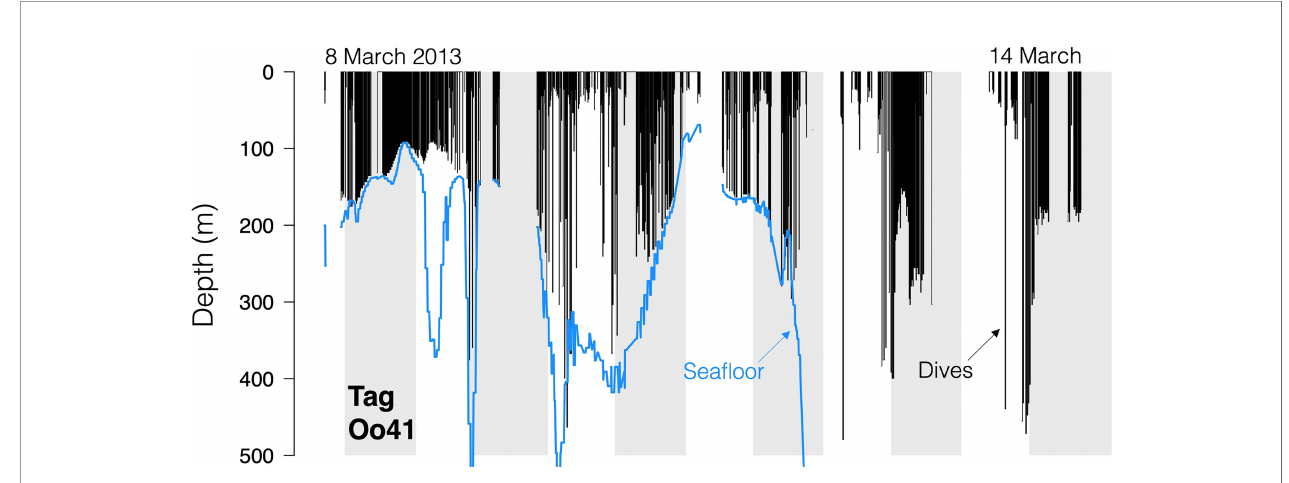
FIGURE 4 | Dive traces for Tag Oo41 (March 2013, off northern California and Oregon and Washington, USA). Black bars are the dives, with line discontinuities representing periods where no dive data was received. Blue line is the local sea fl oor depth.